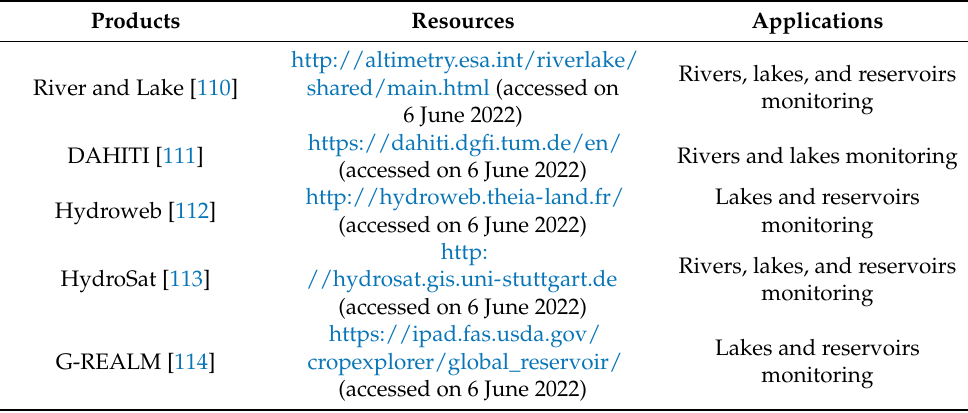
Table 3. Hydrological database using satellite altimetry